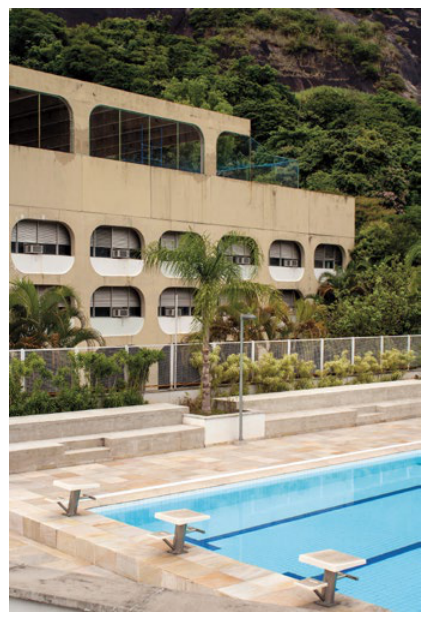
Figure 1 The swimming pool at the CIEP Ayrton Senna Da Silva in the São Conrado neighbourhood, named for Brazil’s legendary Formula One driver. Image © Aberrant Architecture.